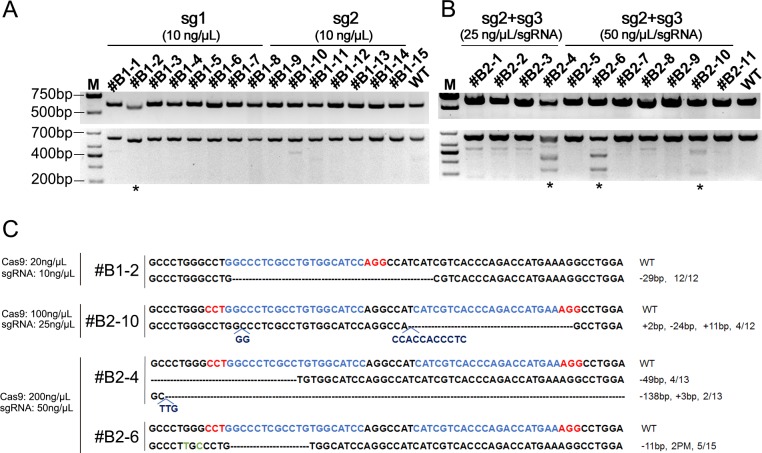
CRISPR/Cas9-mediated one-step generation of BLG KO goats.(A) Top panel: PCR products of the target region of BLG from newborn goats micro-injected with Cas9 and single sgRNA. Bottom panel: Results of T7E1 assay of products shown in the top panel. #B1-1 to #B1-8 were injected with sg1, and #B1-9 to #B1-15 were injected with sg2. (B) Top panel: PCR products of the target region of BLG from newborn goats micro-injected with Cas9 and dual sgRNAs. Bottom panel: Results of T7E1 assay of products shown in the top panel. #B2-1 to #B2-4 were injected with sg2+sg3 (25 ng/μL/sgRNA), and #B2-5 to #B2-11 were injected with sg2+sg3 (50 ng/μL/sgRNA). (C) Sequencing results of BLG-modified kids injected with different concentrations. WT, wild-type. PM, point mutation.